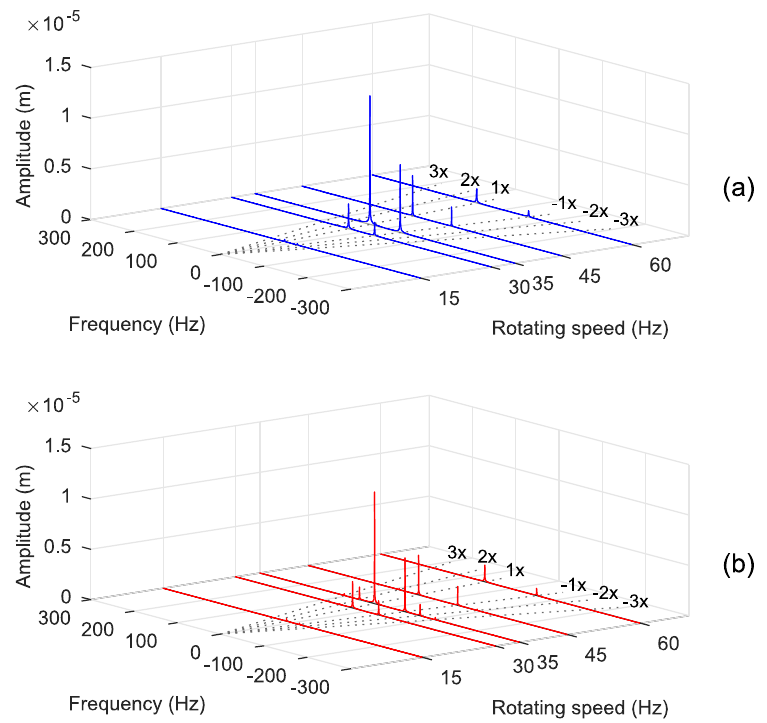
Figure 9. DFT full spectrum of simulated results in elliptical bearing 1 (preload 0.25): ( a ) linear, ( b ) nonlinear. Table 1. Magnitudes of the most relevant peaks of Figure 9—elliptical bearing (preload 0.25).